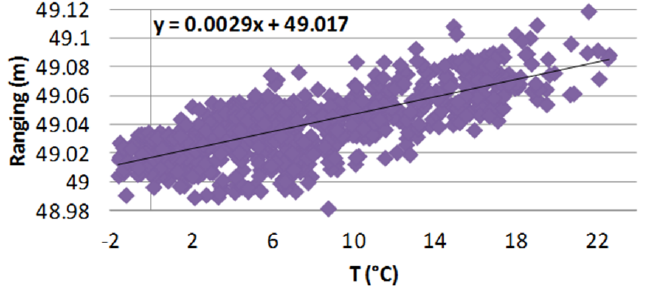
Figure 10. Temperature-measured ranging scatter plot (cluster 1, nodes 1–4, Arcetri test site).